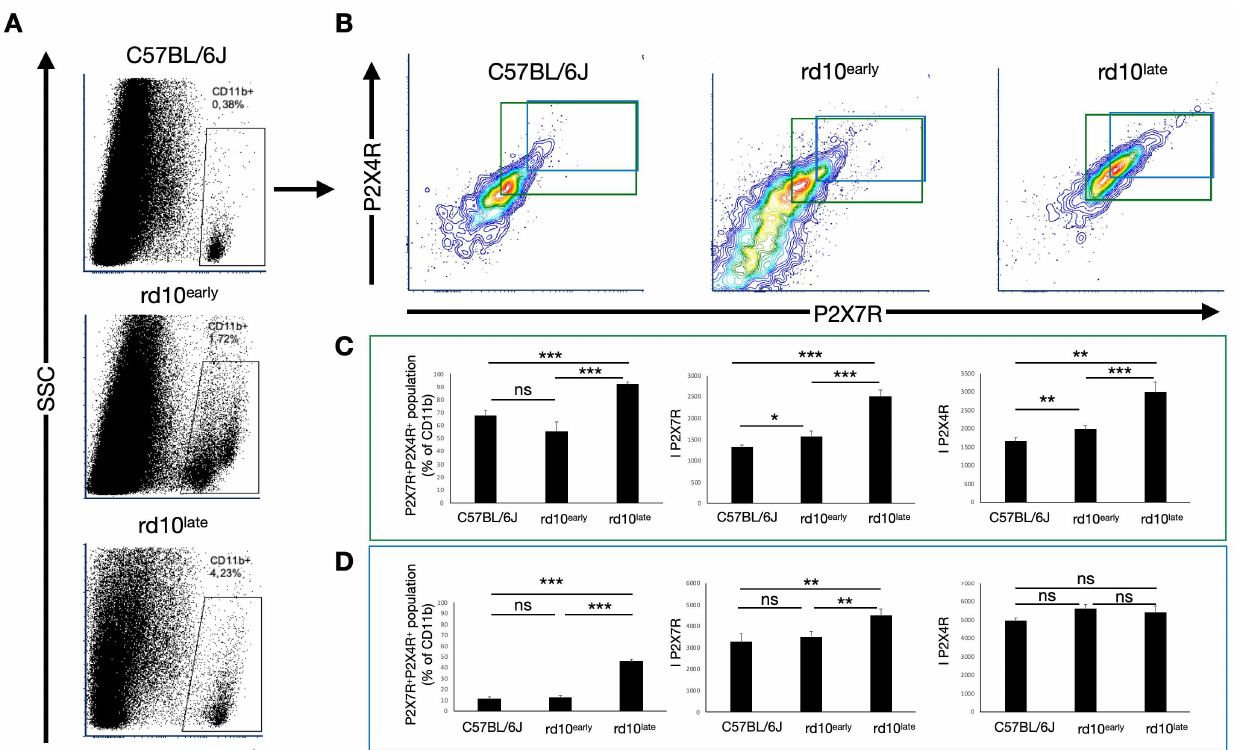
Figure 7. P2X7R and P2X4R expression in the CD11b + population, analyzed by flow cytometry. Whole retinal cells from C57BL/6J, rd10early, and rd10late mice were triple-stained with antibodies against CD11b, P2X7R, and P2X4R. After discarding the cell debris and selecting singlets, CD11b + cells were gated ( A ) and the expression of P2X7R and P2X4R was analyzed ( B – D ). ( B ) Double contour plots representing P2X7R and P2X4R expression, showing P2X7R- and P2X4R-positive populations (green line) and P2X7R- and P2X4R-highly immunoreactive populations (blue line). Each plot shows the sum of a minimum of 3 independent replicates. ( C , D ) Bar graphs showing the number of double-positive cells (P2X7R and P2X4R) and mean fluorescence values for P2X7R and P2X4R in the whole double-positive population ( C ) and the highly immunoreactive double-positive population ( D ). Student’s t -test, * p < 0.05, ** p < 0.01, *** p < 0.001, ns: non-statistically significant. C57BL/6J: postnatal day (P)47; rd10early: P18 and rd10late: P44.